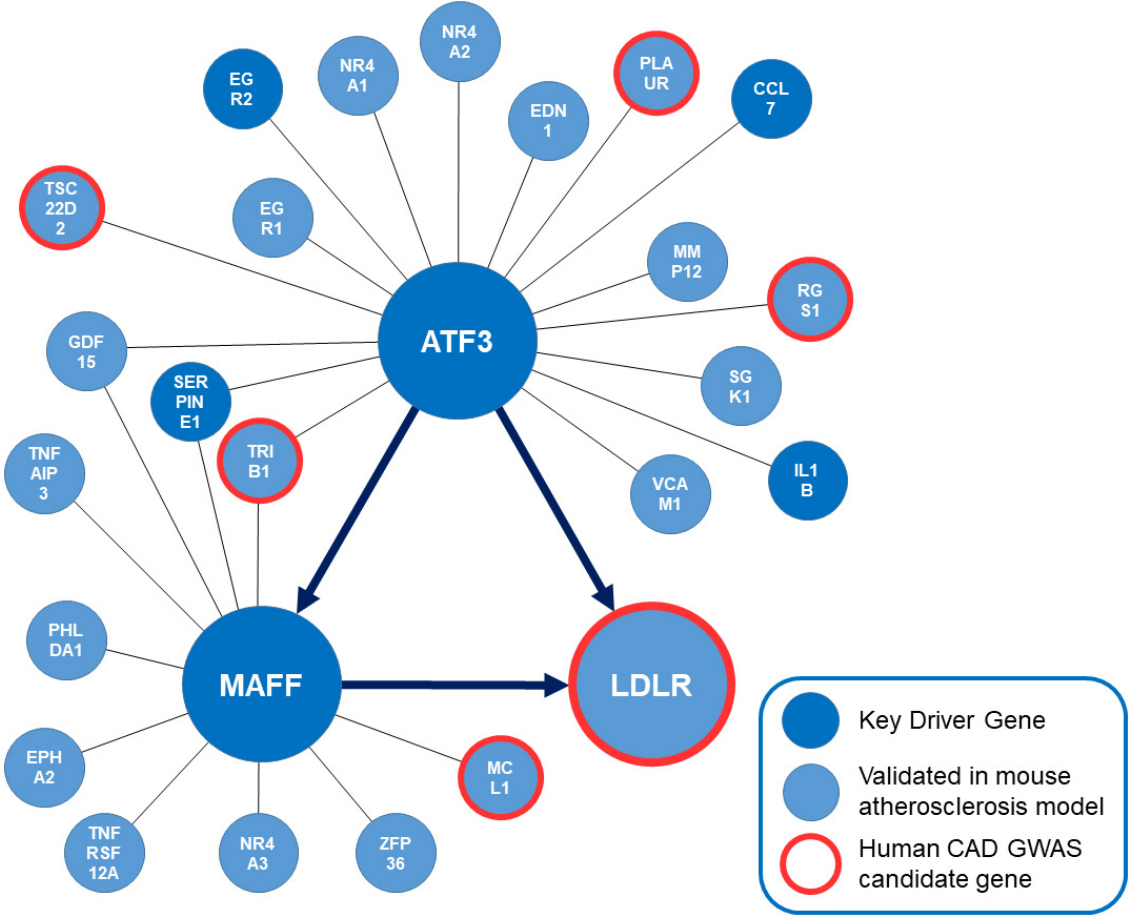
Figure 2. Subnetwork orchestrated by ATF3. Key driver genes of the overall modeling approach are shown in dark blue. Genes that have been validated to affect atherosclerosis in genetically engineered mouse models are shown in light blue. Human CAD GWAS candidate genes are highlighted in red. The bioinformatically predicted directionality of regulation between ATF3, MAFF and LDLR in this liver-specific regulatory network is implemented. ATF3: Activating transcription factor 3F; CAD: coronary artery disease; GWAS: Genome wide association study; LDLR: low-density lipopro- tein receptor; MAFF: MAF basic leucine zipper transcription factor F.